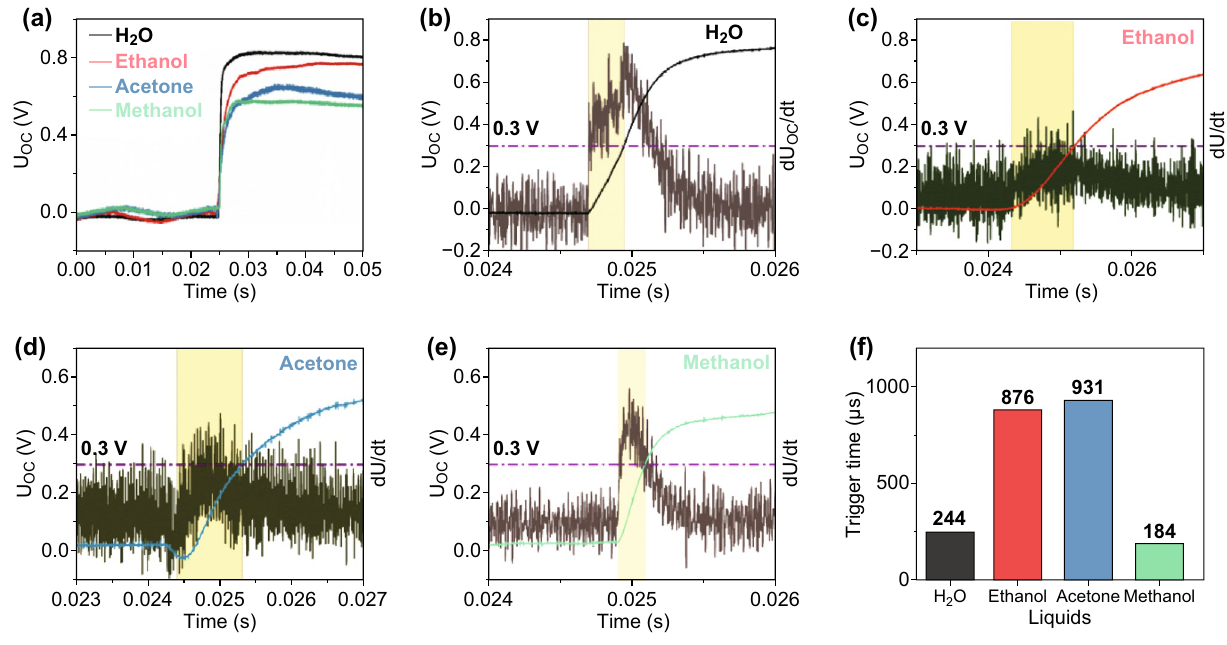
Fig. 4 a Time dependence of the voltage response of the C-T generator for several liquids recorded with a fast oscilloscope (data acquisition frequency 1 MHz). Black, red, blue, and green curves response to H 2 O, ethanol, acetone, and methanol. Expanded U OC ( t ) plot of the initial response to droplets of H 2 O, ethanol, acetone, and methanol is shown in b – e . The purple curve in each figure plots d U OC /d t , while the trigger voltage was set to 0.3 V. f Effective trigger time for each liquid, defined as the time that the open-circuit voltage reaches 0.3 V. (Color